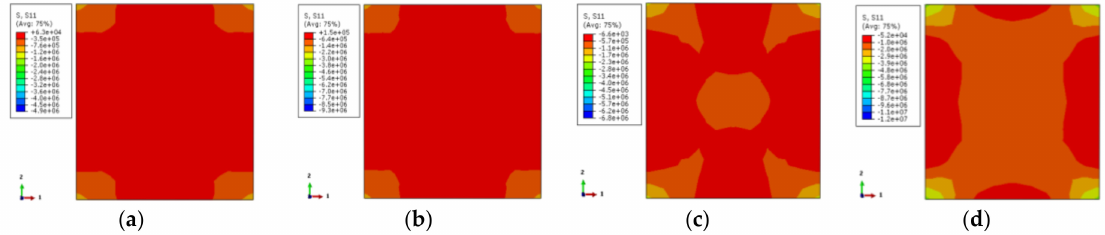
Figure 15. The lateral stress distribution of concrete ( a ) DS-600-0-0.75 ( b ) DS-600-0-1 ( c ) DS-600-0.75 ( d ) DS-600-1.